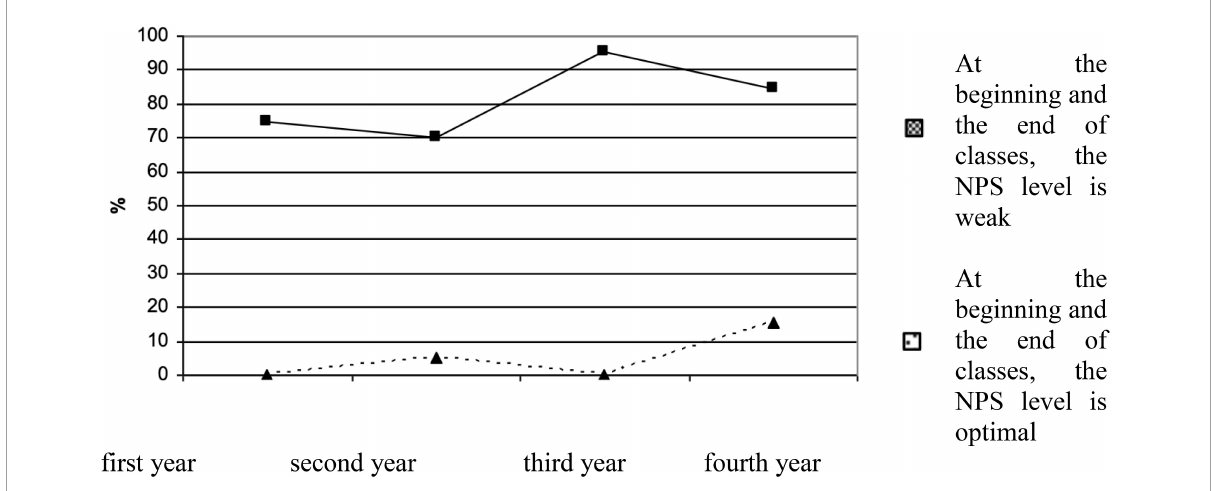
FIGURE3 Frequency of occurrence of different variants of the zero shift in the level of neuropsychic strain in psychology students of the first age subgroup (in %).